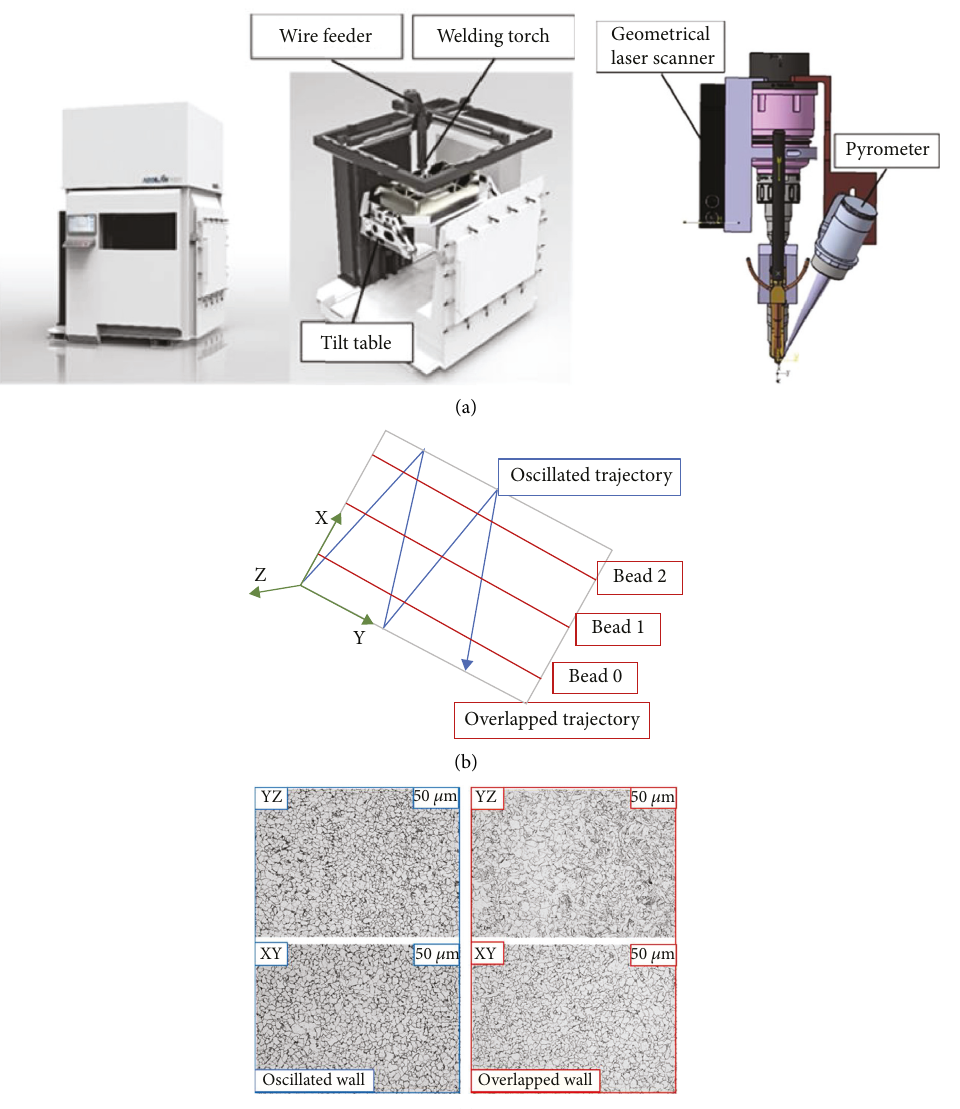
Figure 3: (a) 3 +2-axis ADDILAN machine and the welding torch. (b) Paths of overlapping and oscillating strategies. (c) (left) Mi- crostructure of the center parts of the oscillated wall in YZ and XY planes; (right) microstructure of the overlapped wall in YZ and XY planes.